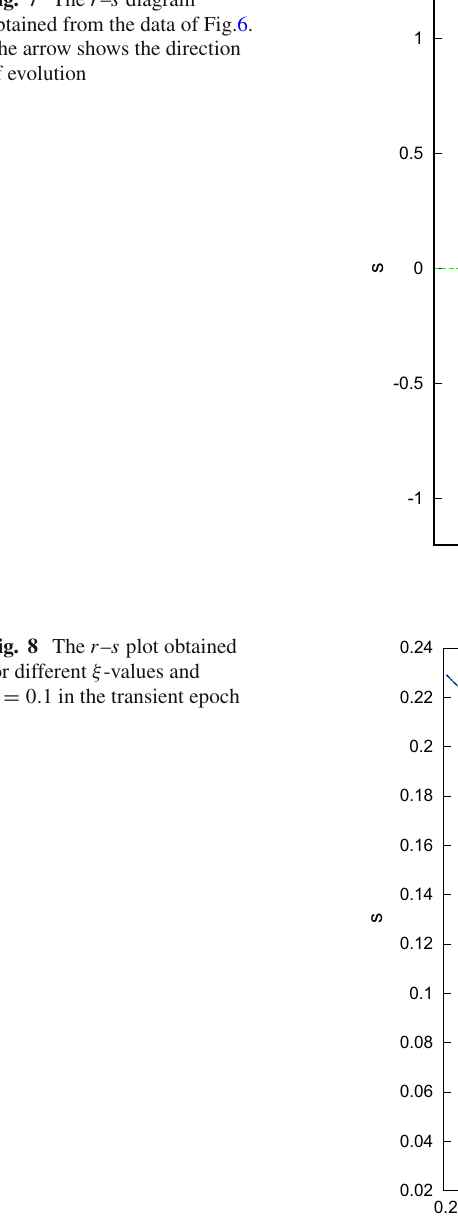
Fig. 8 The r – s plot obtained for different ξ -values and α = 0 . 1 in the transient